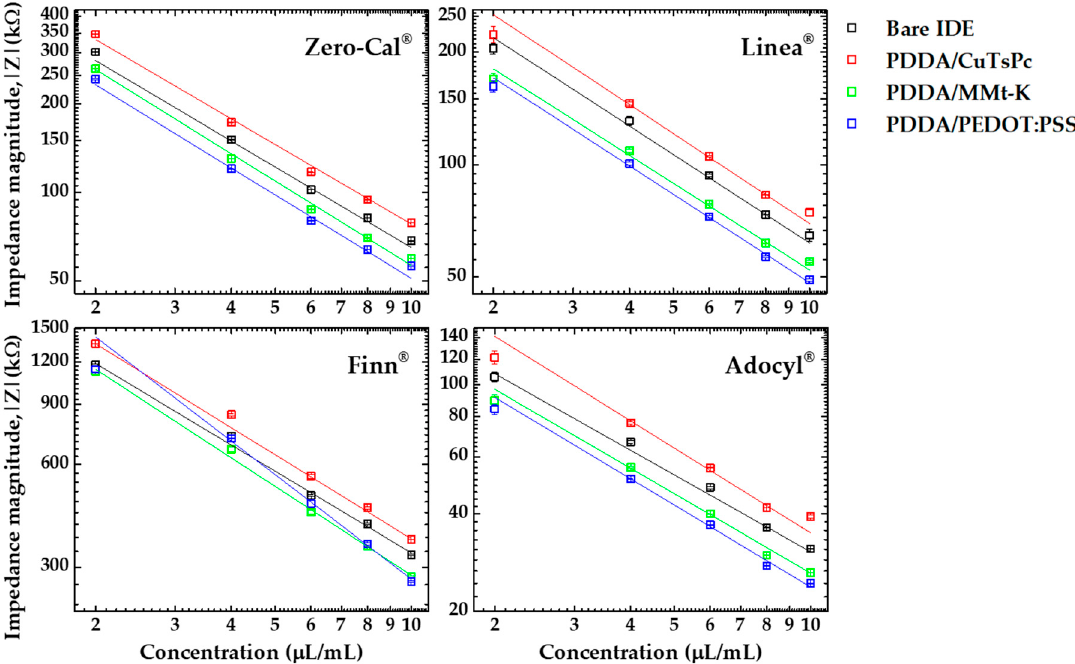
Figure 16. Impedance magnitude data at 1 kHz for each sensing unit evaluated at distinct concentrations (from 2 to 10 µL/mL) of four sucralose-based sweeteners using a microfluidic e-tongue under 5 mL/h flow rate. Table 1. Limit of detection (LD), limit of quantification (LQ), and sensitivity for the sucralose-based sweeteners using bare IDE, PDDA/CuTsPc, PDDA/MMt-K, and PDDA/PEDOT:PSS as sensing units in the microfluidic e-tongue device.